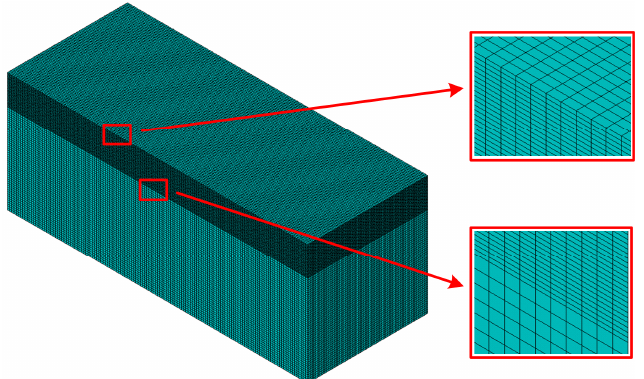
Figure 2. Mesh division of workpiece.